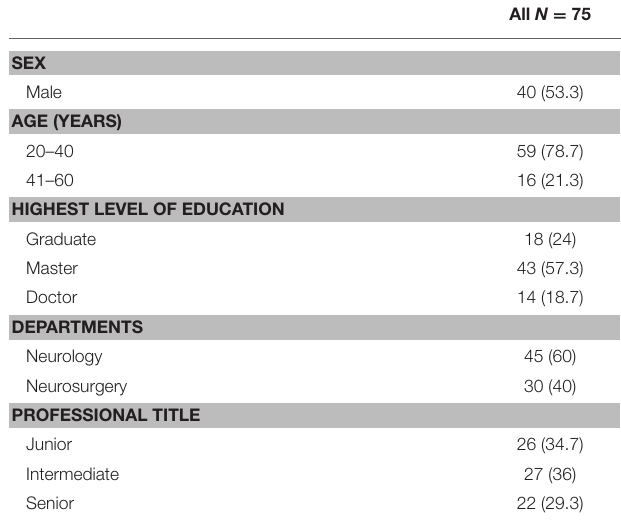
TABLE 3 | Characteristics of cooperative hospital related to ICH management*. Variable